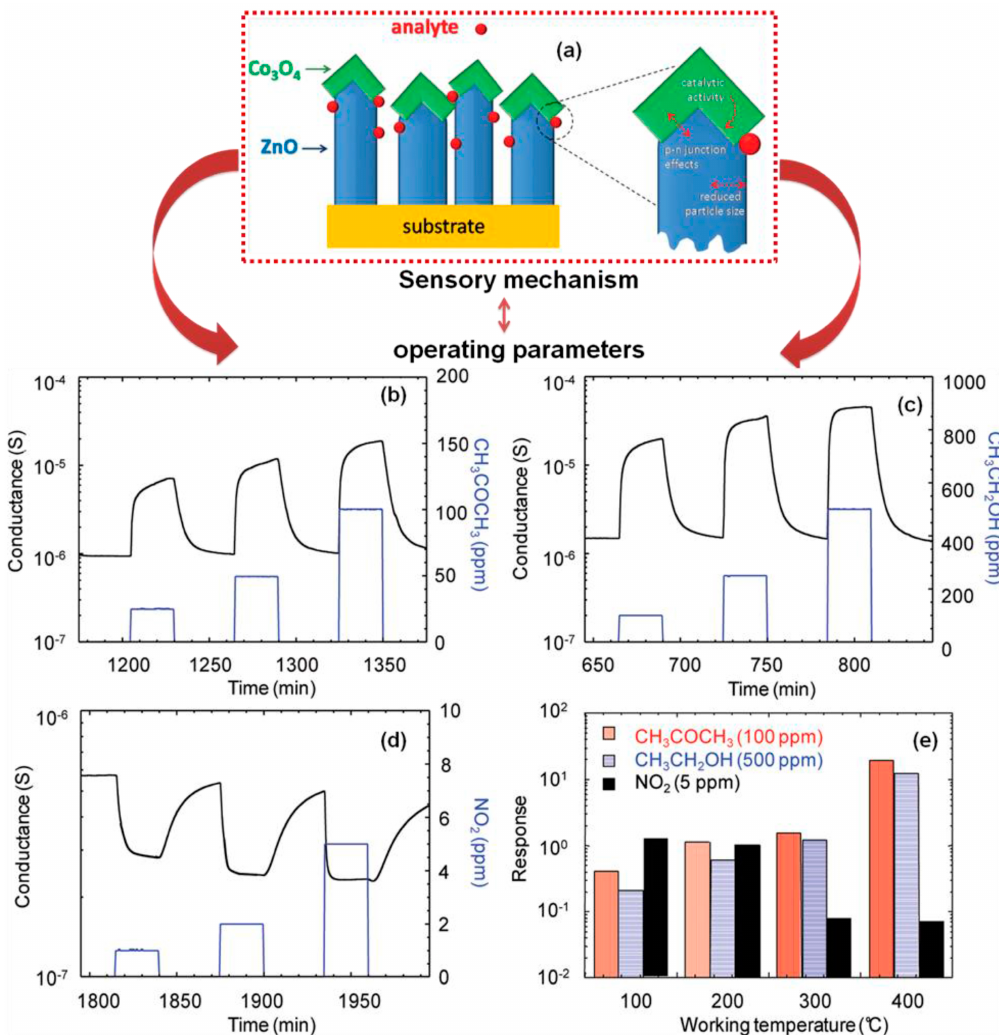
Figure 7. ( a ) Schematic representation of the main phenomena beneficially affecting the sensing behavior of the present Co 3 O 4 /ZnO nanocomposites. Sensing responses (black) of a Co 3 O 4 /ZnO sensor (specimen ZnCo 10 ) toward square concentration pulses (blue) of ( b ) CH 3 COCH 3 ; ( c ) CH 3 CH 2 OH; and ( d ) NO 2 . Working temperatures were (a) 400 °C and (b) 200 °C; ( e ) Dependence of the response on the operating temperature for selected analyte concentrations (specimen ZnCo 10 ). Adapted figure from [81] with permission from copyright (2012), American Chemical Society (Washington, DC, USA).